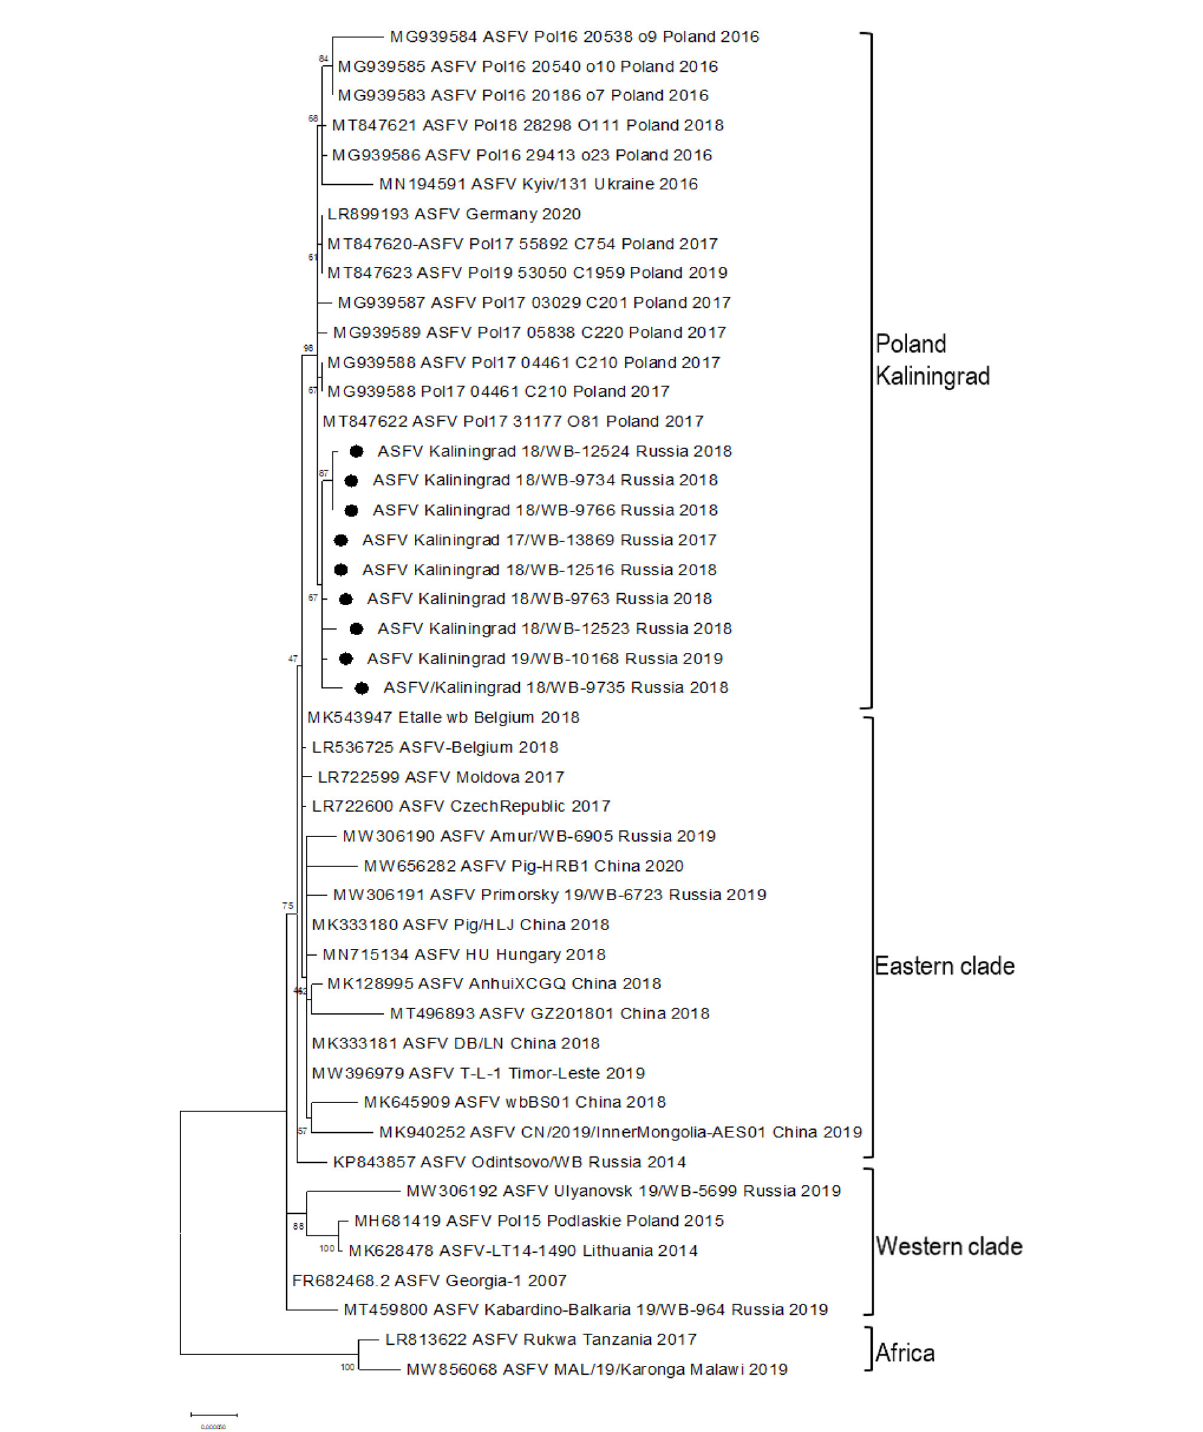
FIGURE2 Maximum likelihood phylogenetic tree of the whole-genome sequences of selected ASFV genotype II. Sequences from isolates obtained in Kaliningrad are indicated with black circles. The sequences from Kaliningrad, Poland, Germany, and the Ukraine cluster are in a unique sister lineage to the previously described eastern and western